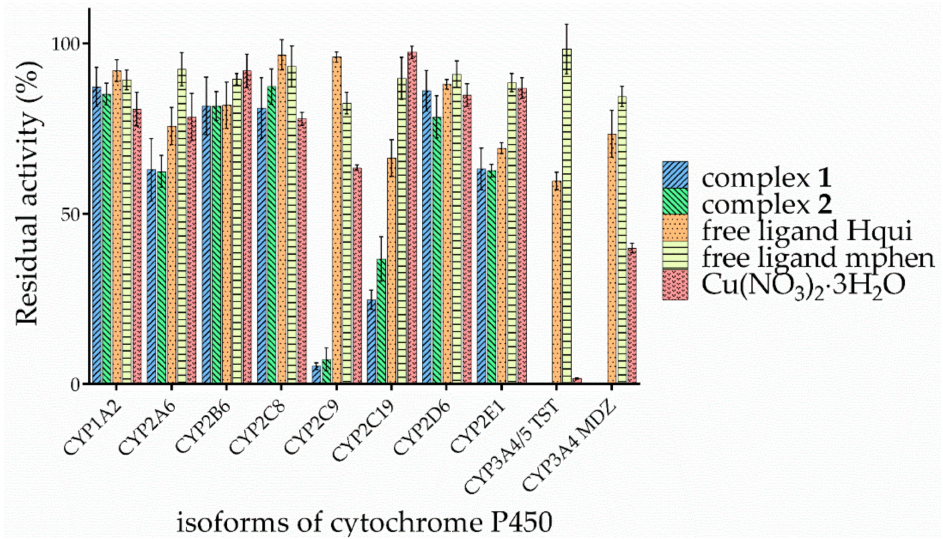
Figure 3. Overview of inhibition rates of CYP activities with specific substrates by the copper(II) complexes 1 and 2, free Hqui and mphen ligands, and Cu(NO 3 ) 2 · 3H 2 O at 100 µ M concentration. The results represent the amount of residual activity of CYPs expressed as a percentage of the activity of an uninhibited